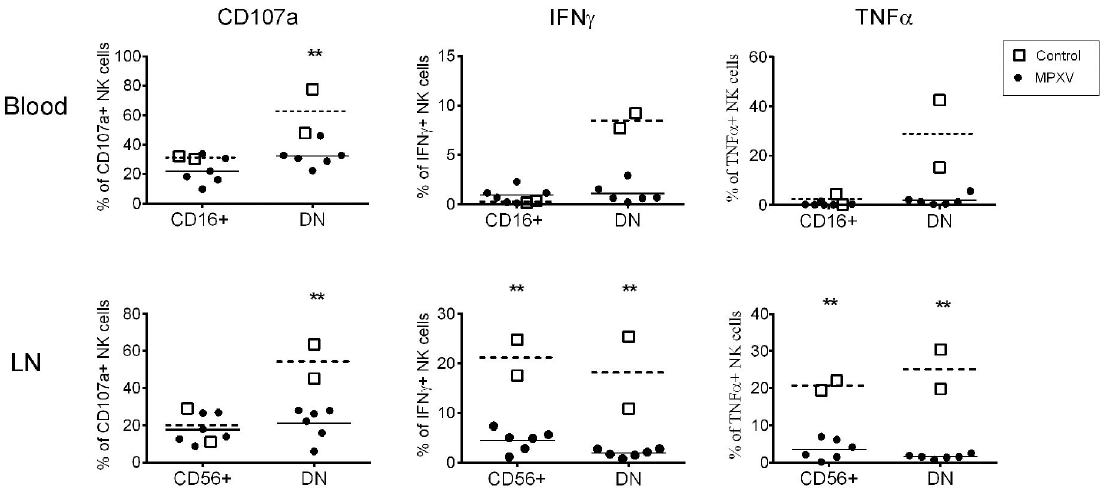
Figure 6. Compromised NK cell functions upon MPXV infection. Frequency of the expression of CD107a, IFN-γ, and TNF-α by different NK cell subsets from day 8-9 blood and LN samples is shown. Calculation of mean frequency of expression from control (dotted line) and MPXV-infected NHPs (solid line) was performed with Prism. Statistical analyses were permutation re-sampling tests with Bonferroni-adjusted P-values computed using R